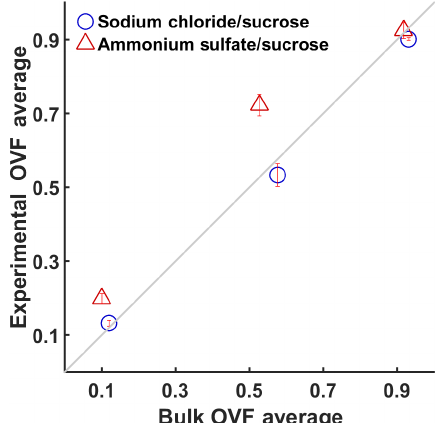
Figure 8. Correlation between experimentally determined and bulk OVF averages using sodium chloride and adipic acid as the assumed inorganic and organic,